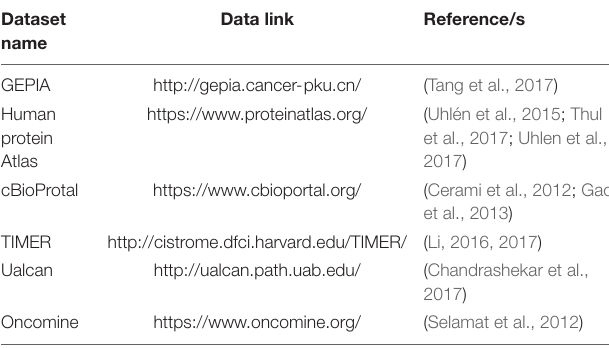
TABLE 2 | Validation databases for colon and rectal cancer.